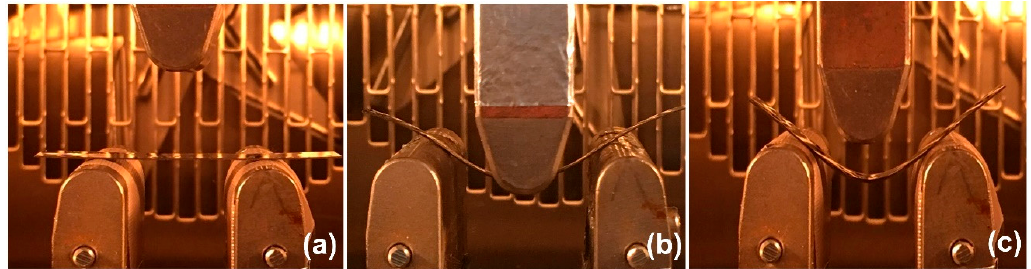
Figure 9. Photographs showing shape fixity process under a three-point bending load for MWCNT reinforced V-fa/ECO composites: ( a ) the original rectangular shape, ( b ) deformed temporary shape at T g + 20 °C with 10% bending, and ( c ) fixed temporary shape at room temperature.